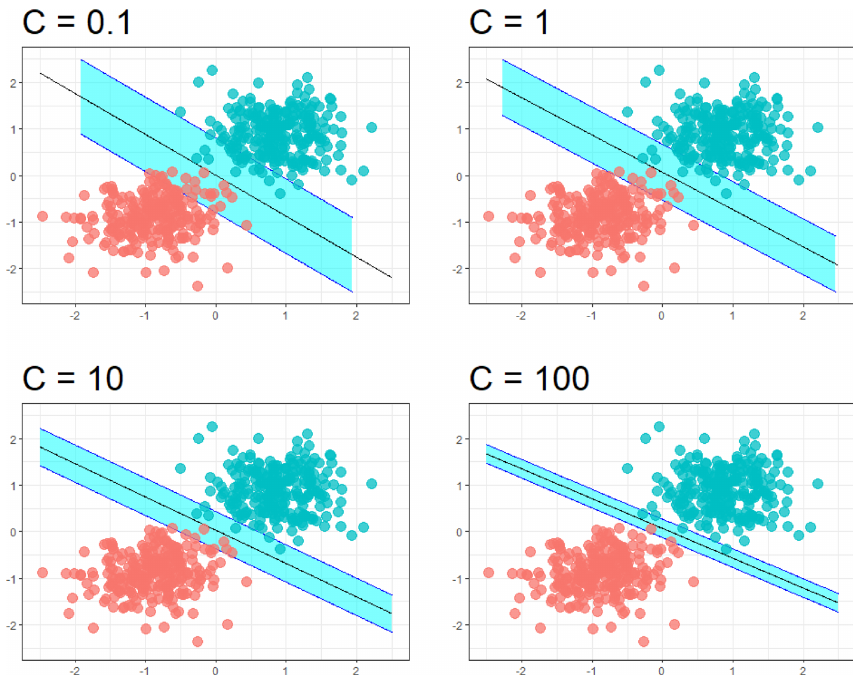
Figure 3. Decision boundary of the support vector machine’s algorithm, with changing regularisation parameter C